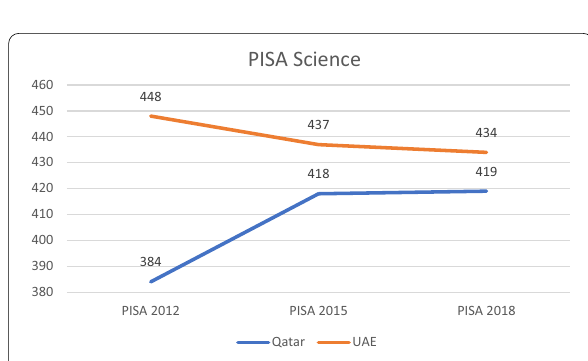
Fig. 6 PISA Science performance (Qatar and the